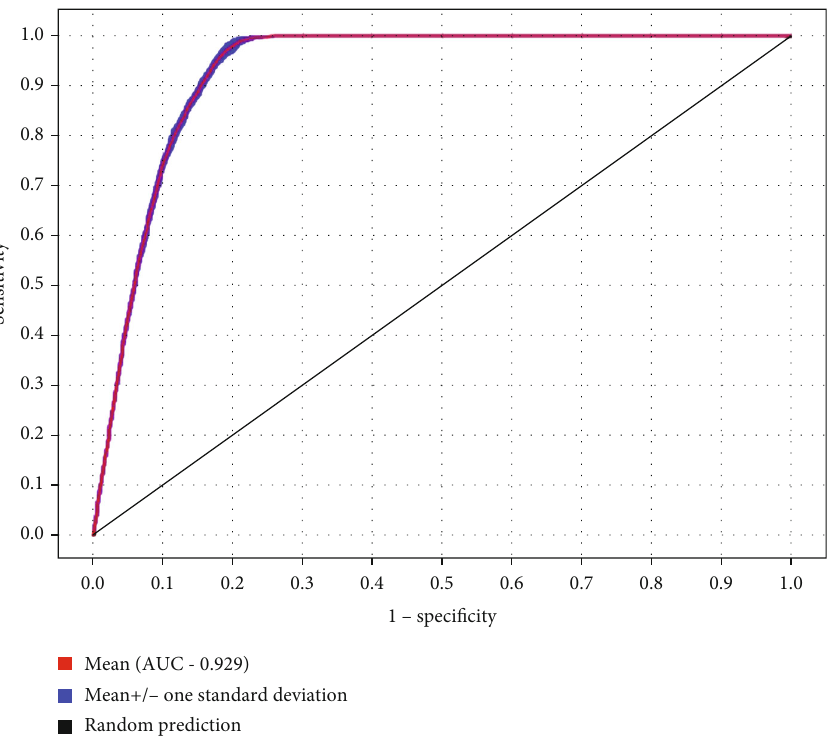
Figure 7: Average test AUC of the MaxEnt model with 20 repetitions.